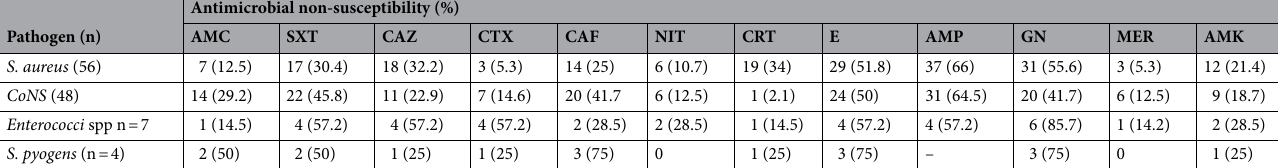
Table 4. Non-susceptibility rates of the gram positive bacteria. CoNS , Coagulase Negative Staphylococci; AMC, Amoxicillin-Calvulanic acid (20/10 μg); SXT, cotrimoxazole (25 μg); CAZ, Ceftazidime (30 μg); CTX,